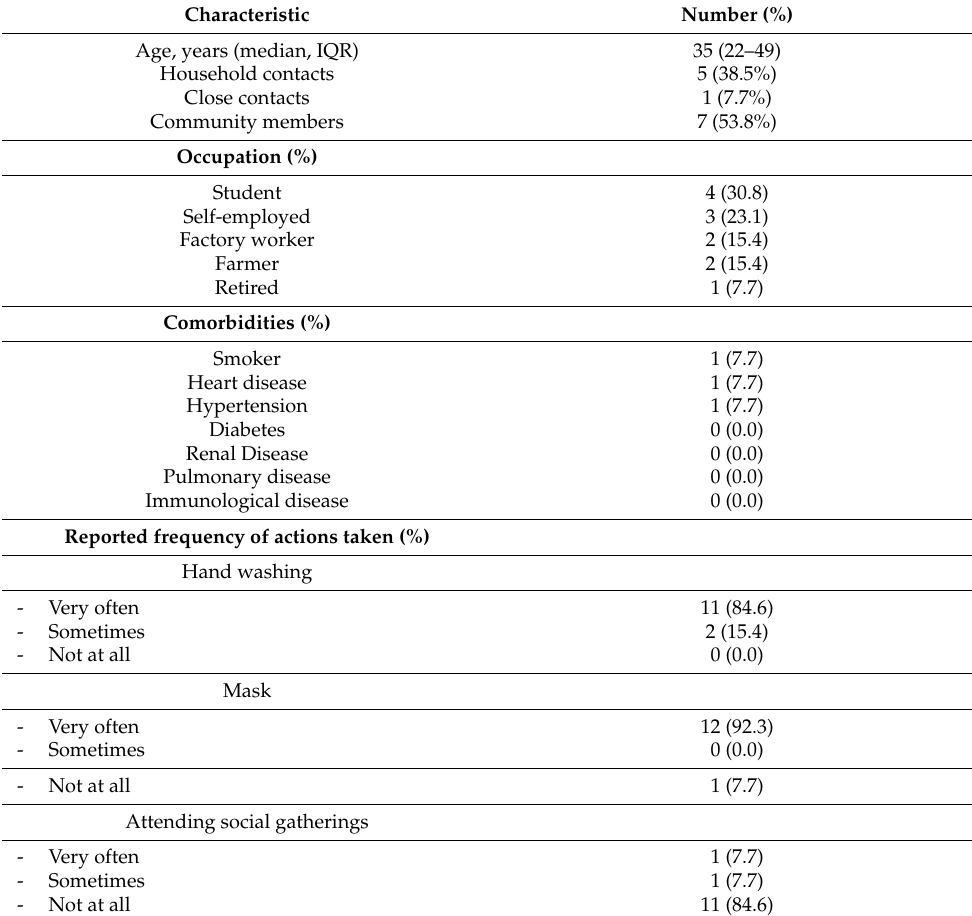
Table 5. Characteristics of individuals positive for